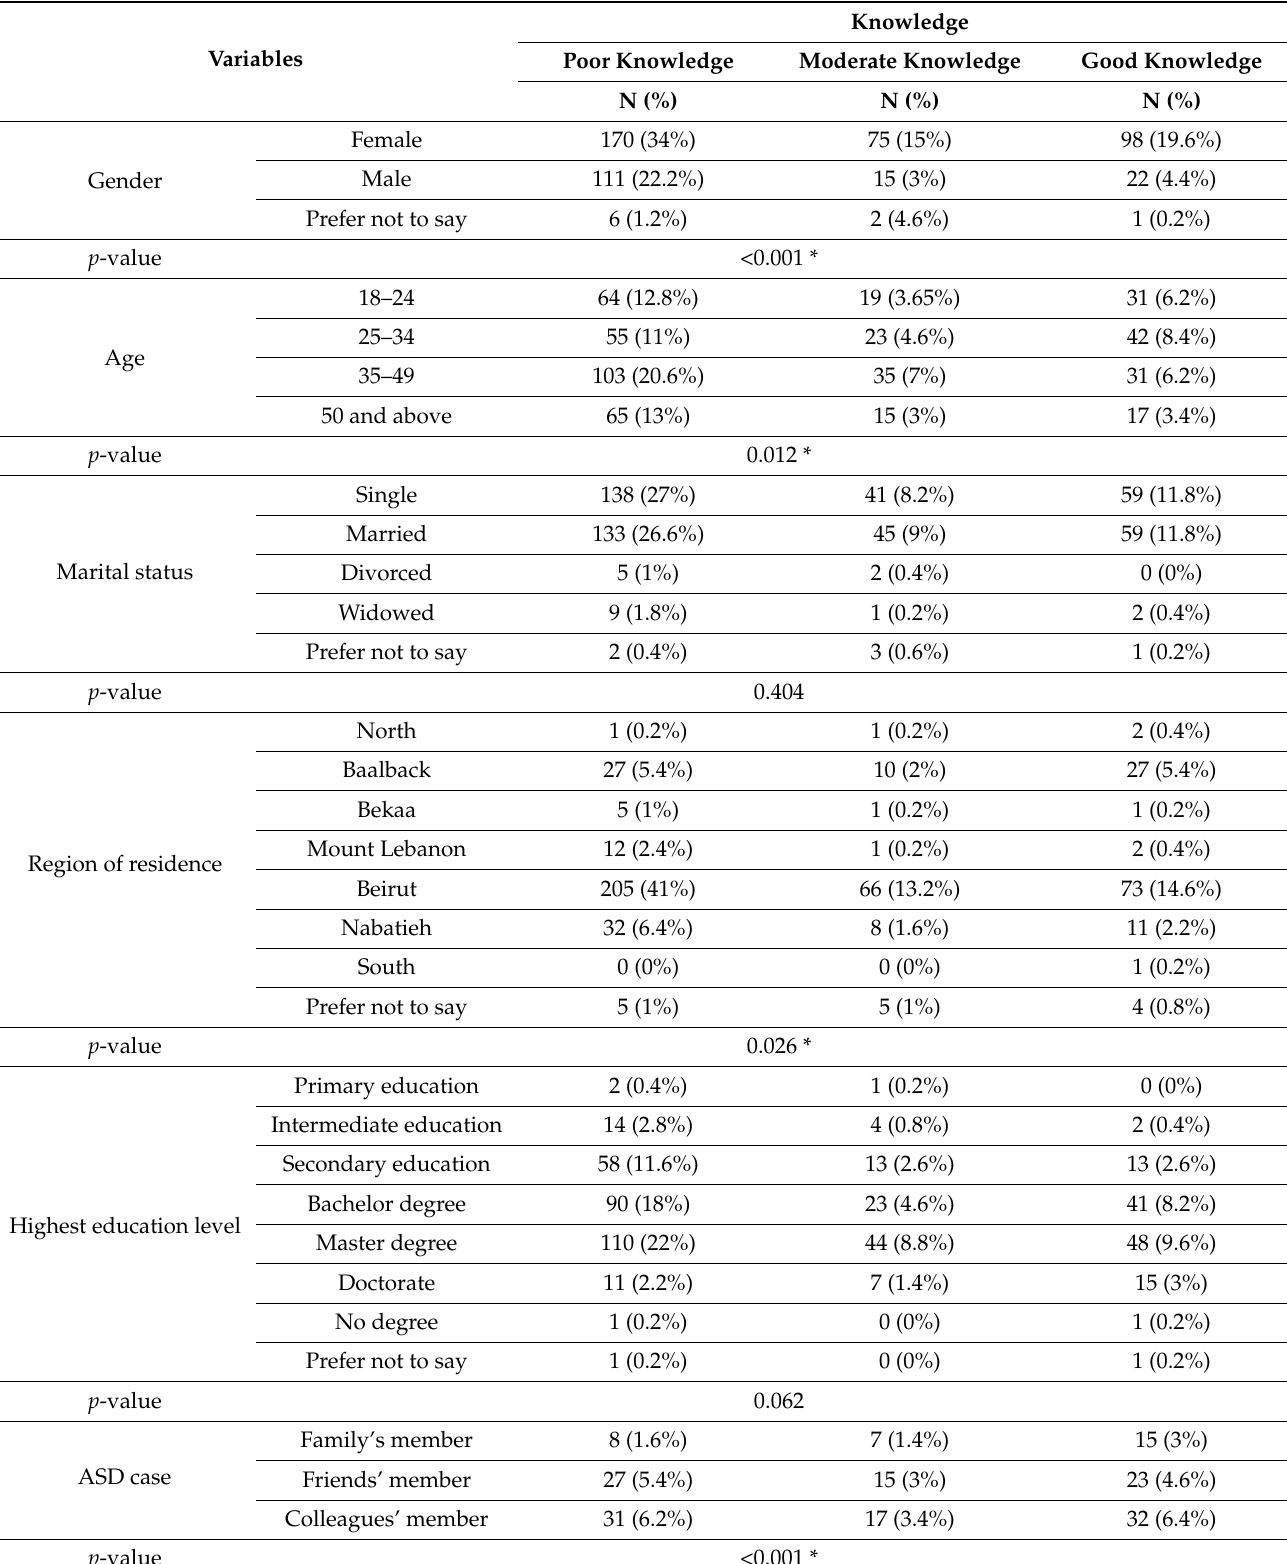
Table 6. Comparison of knowledge scores according to socio-demographic